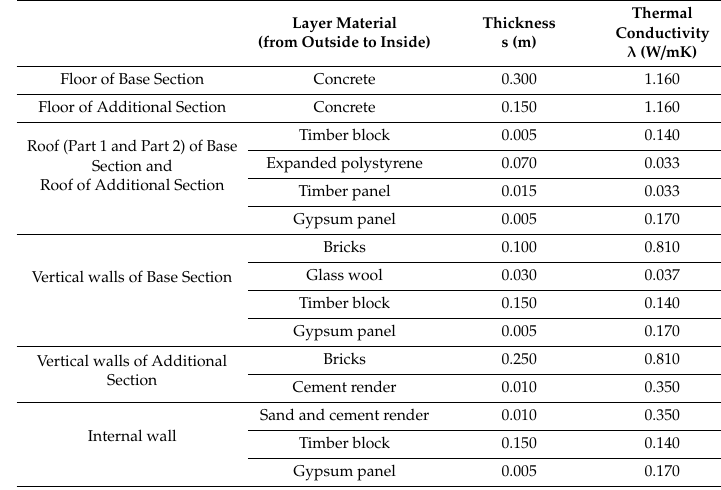
Figure 3. Architectural model of the Mongolian detached house. Table 1. The materials of the walls of the house.